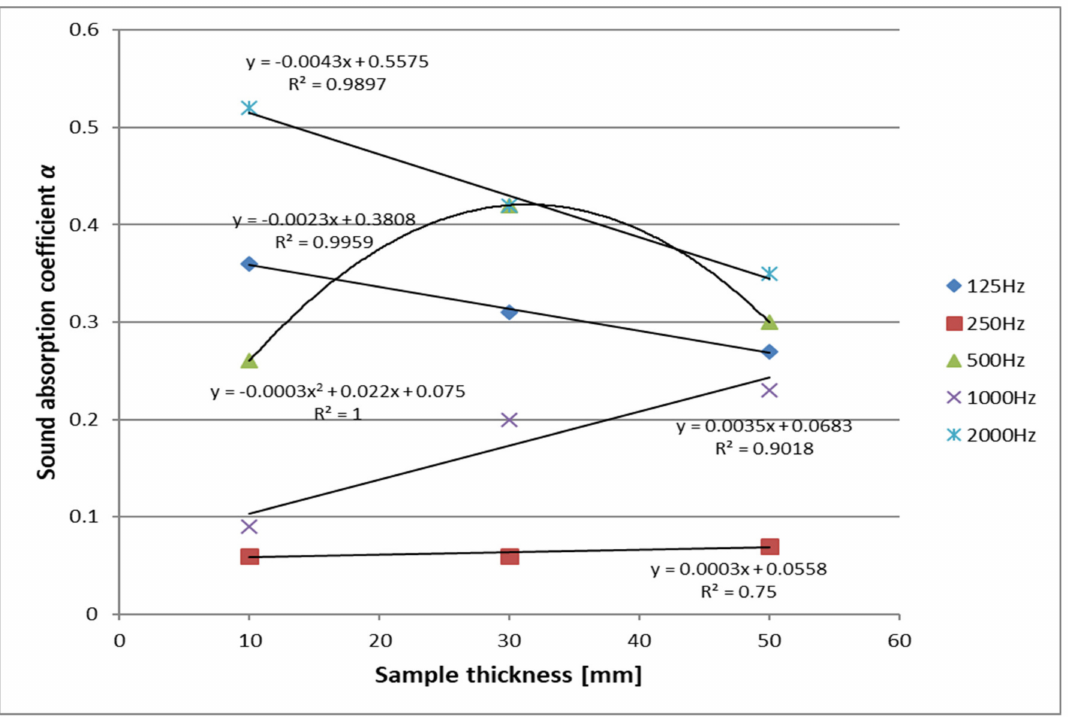
Figure 9. Sound absorption coefficient dependence on the thickness of the sample of mixture Z2 (the trendline is reported for each set of